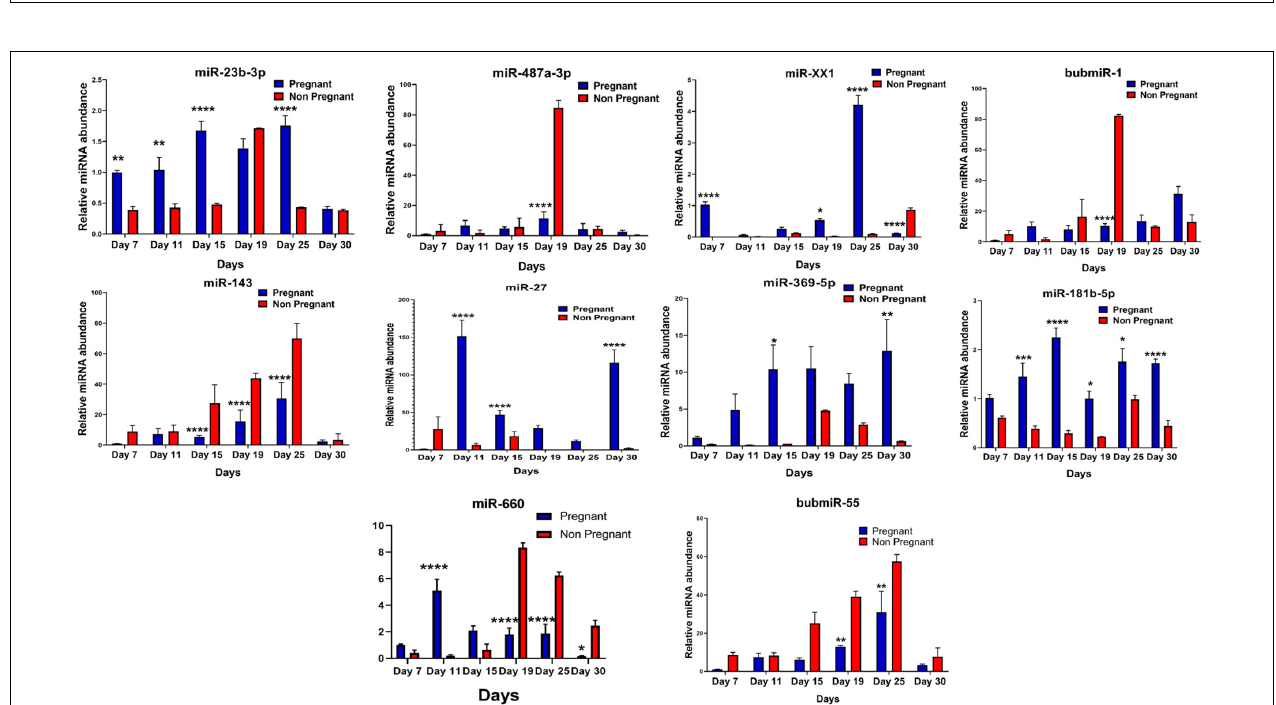
FIGURE 5 | Graphical representation of the abundance of shortlisted miRNAs in the blood plasma of pregnant and non-pregnant animals. Here, X axis represent the relative miRNA abundance and Y axis represent the Days. Blue and red columns represent pregnant and non-pregnant animals. * p < 0.05; ** p < 0.01; *** p < 0.001; and **** p <